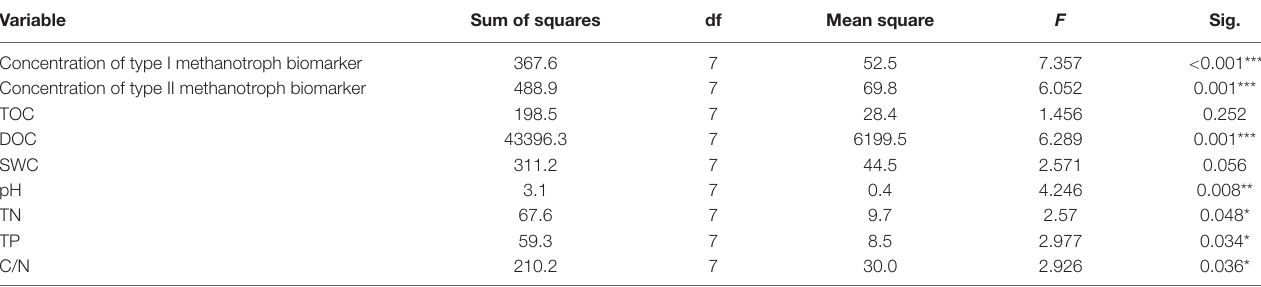
TABLE 2 | A summary of analysis of variance (one-way ANOVA) on the effect of the altitude for soil environmental variables, and the concentrations of type I and type II methanotroph biomarkers. Variable Sum of squares df Mean square F Sig.